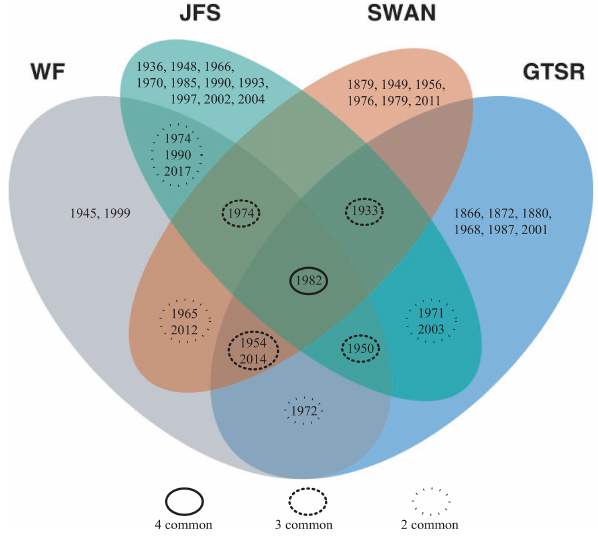
Figure 7. Venn diagram of avalanche years common between sub- regions. Overlapping areas of each ellipse indicate years in common with each